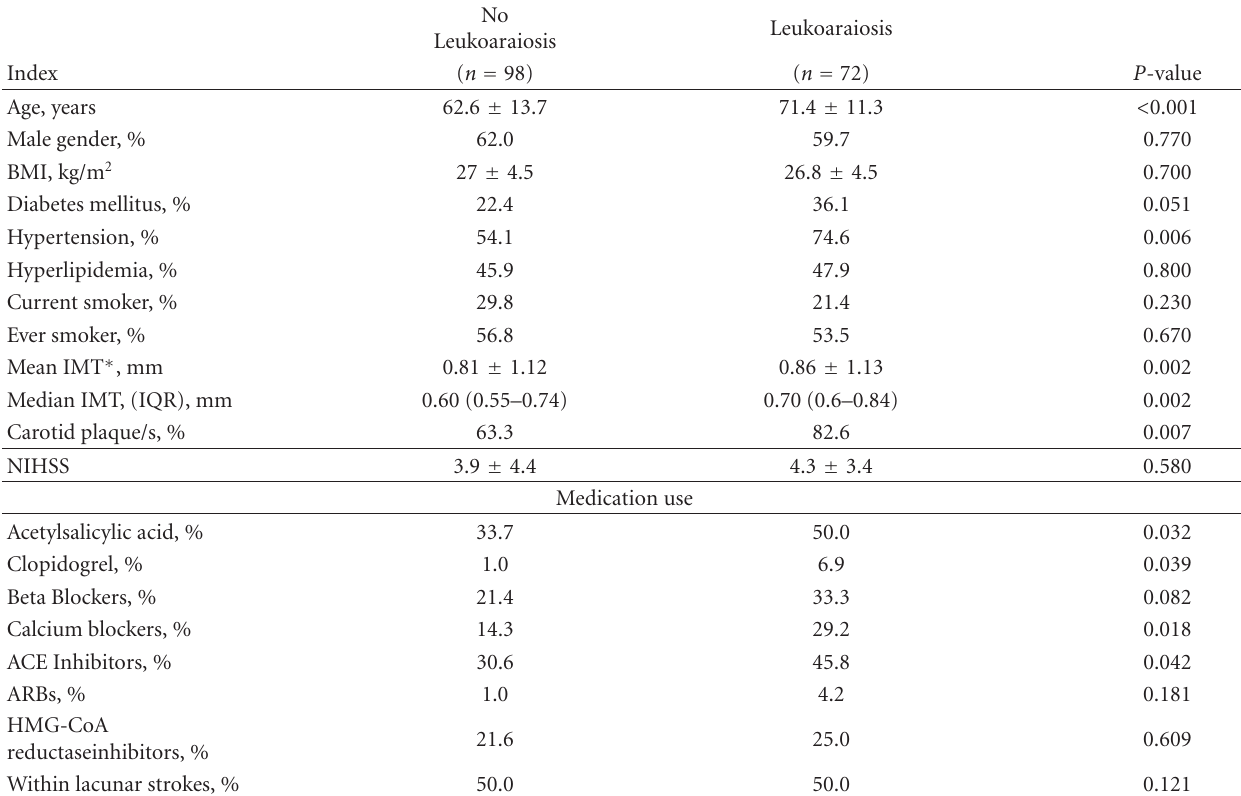
Table 1: Risk factors and clinical characteristics of stroke patients with and without leukoaraiosis.